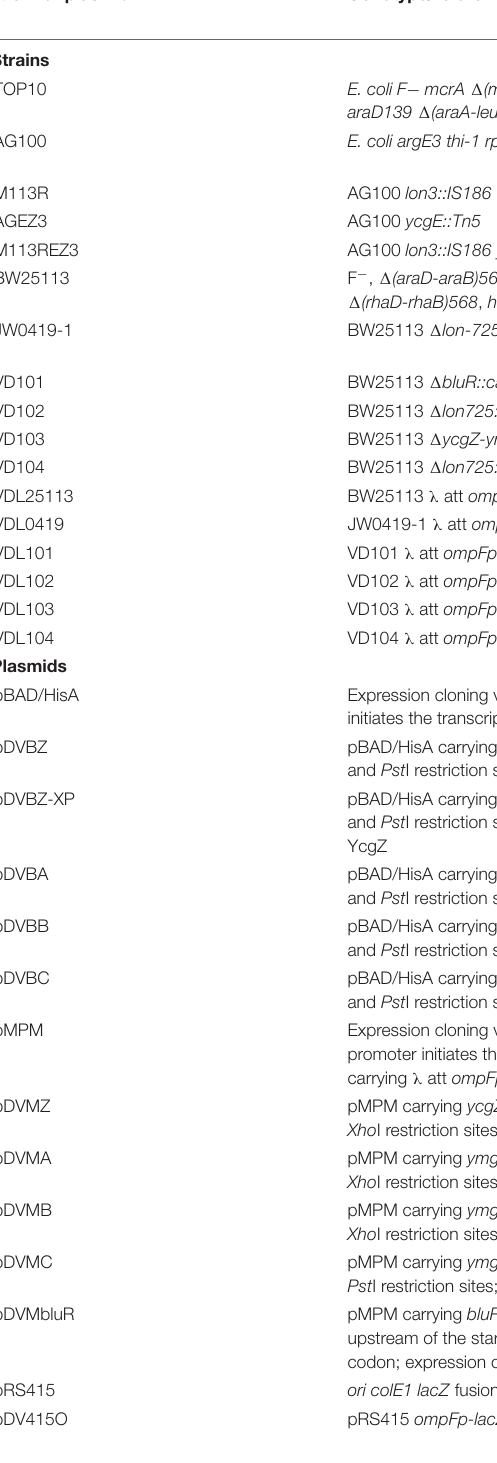
TABLE 1 | Bacterial strains and plasmids used in this study. Strain or plasmid Genotype/relevant